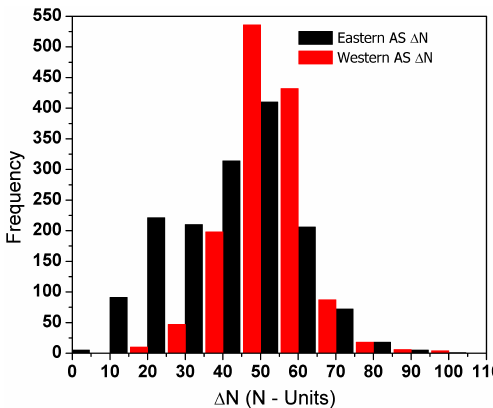
Figure 10. Frequency of (cid:49)N observed in the western AS and east- ern AS during monsoon season of the years 2009–2013 for various ranges of (cid:49)N by COSMIC. The western AS shows higher values, meaning inversion is